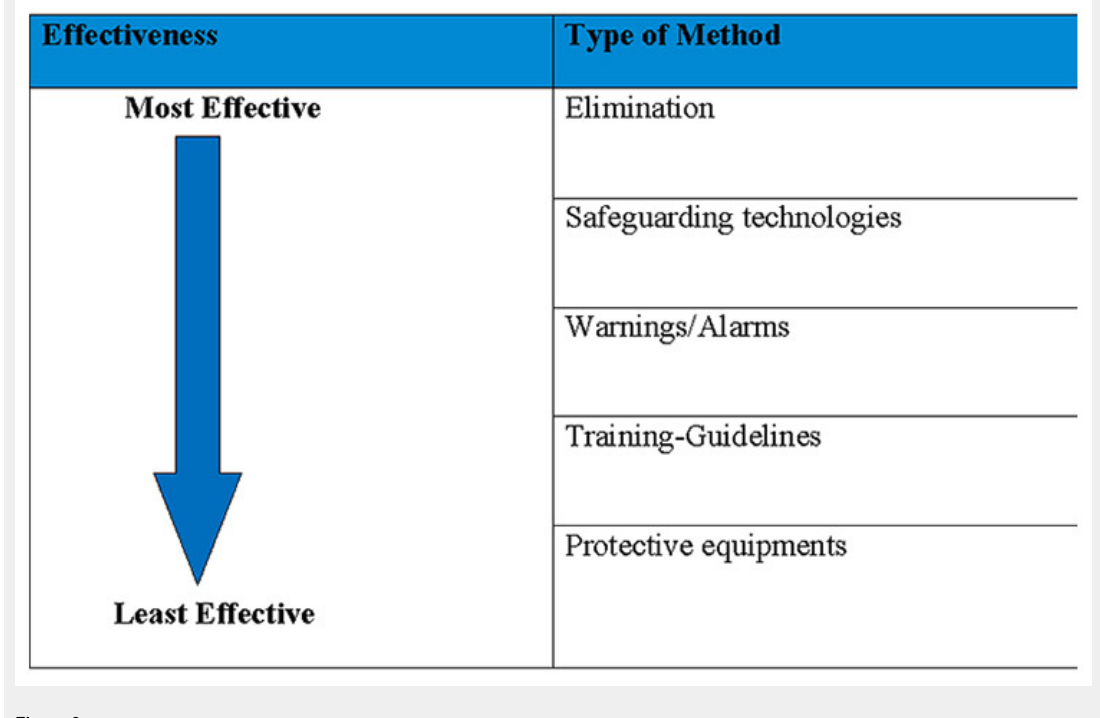
Figure 3 Safety hierarchy